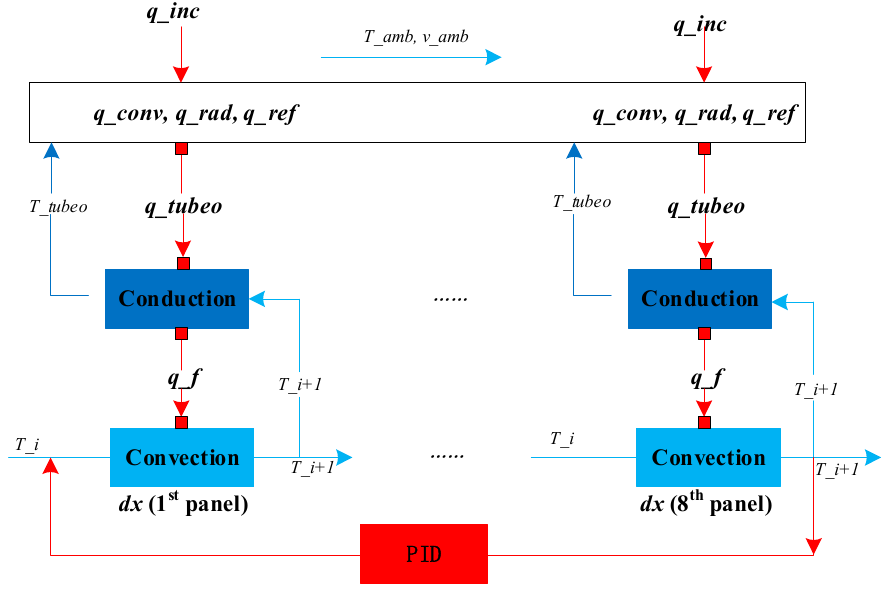
Figure 3. Calculation flow chart of the model.